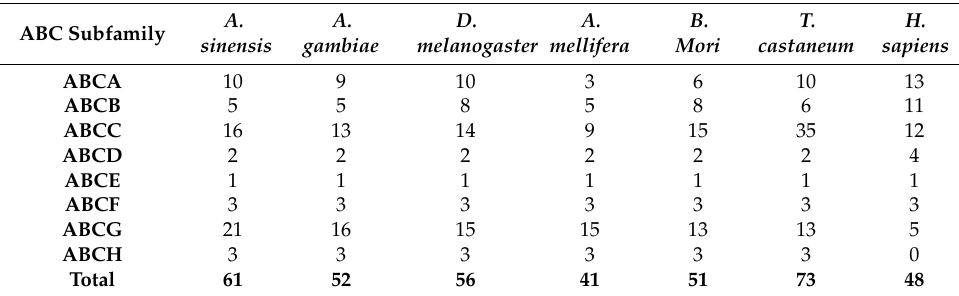
Table 2. Gene number comparison of eight ABC transporter subfamilies among genomes of A. sinensis , five other insect species, and human